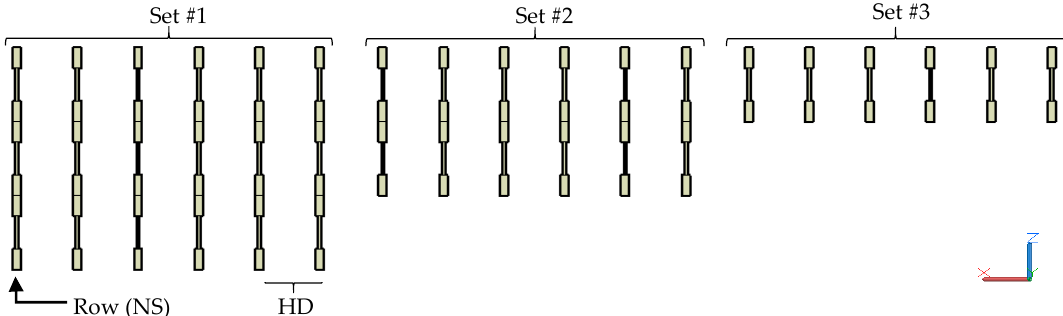
Figure 6. Definition of the various parameters in the arrangements of sleepers in the vertical direction: Sets, HD, and row determination.